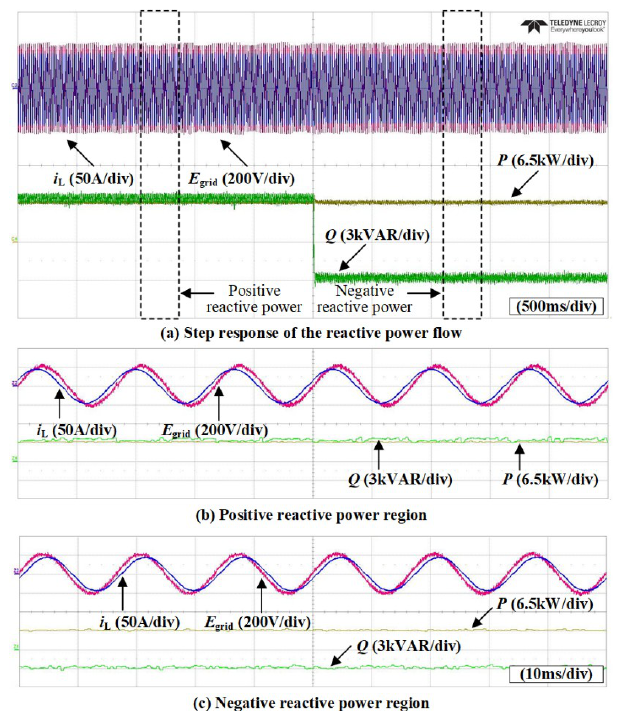
Figure 13. Experimental results of active and reactive power flow control method when the power factor changes from leading to lagging: ( a ) step response of the reactive power, ( b ) PF = 0.432 leading and ( c ) PF = 0.432 lagging.